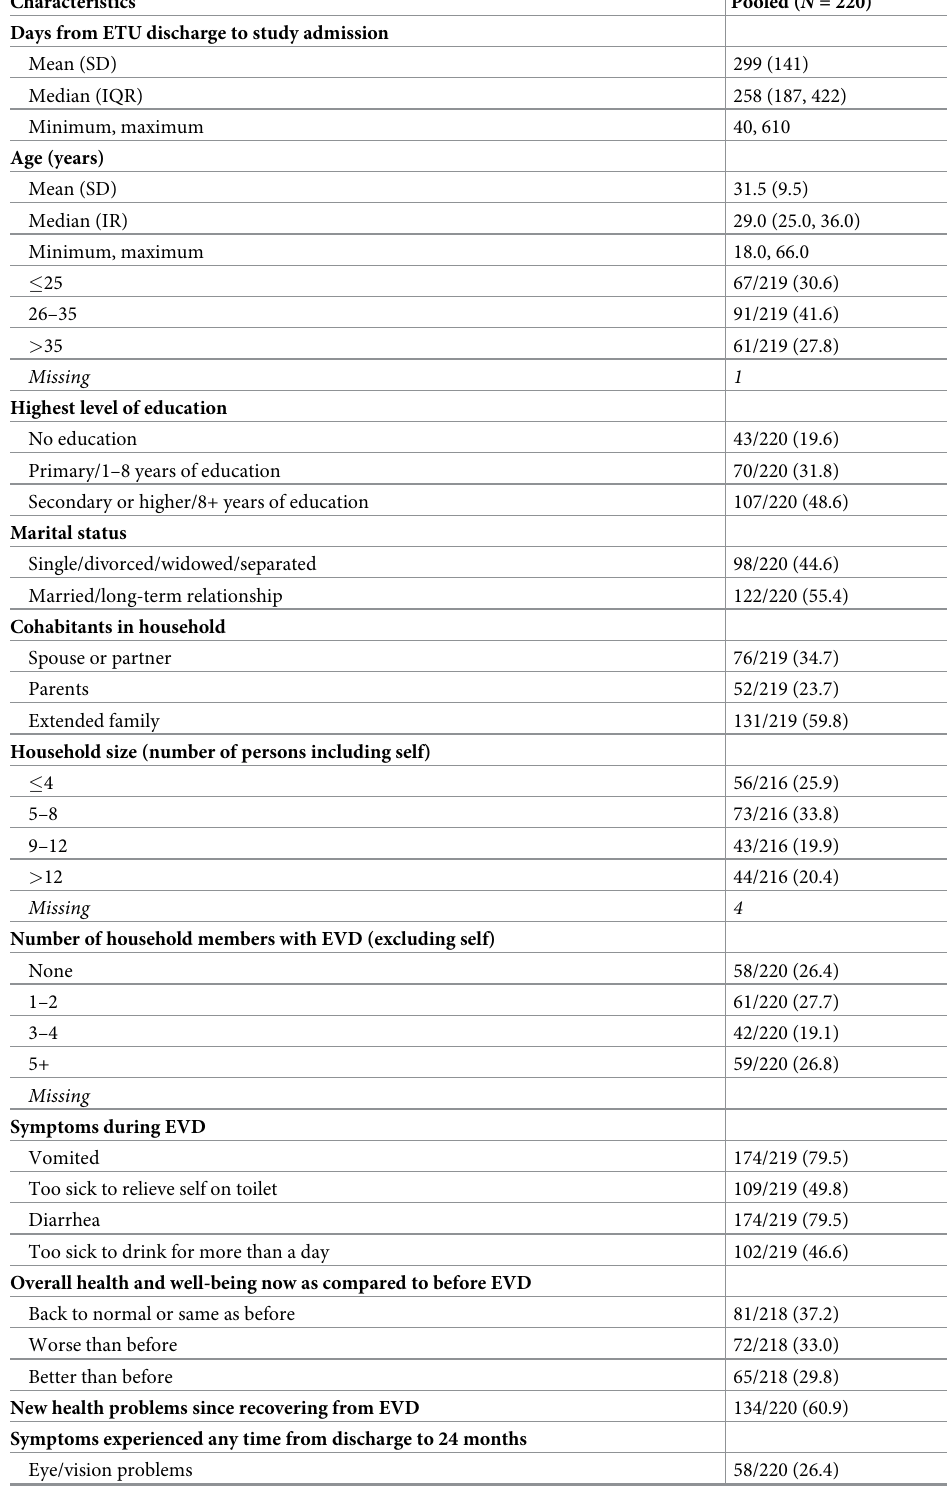
Table 1. Baseline characteristics of EVD survivors enrolled in the study.